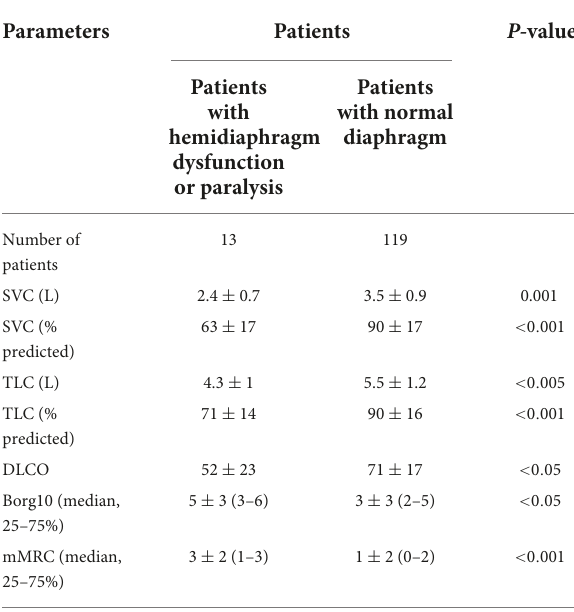
TABLE 4 Pulmonary function test.